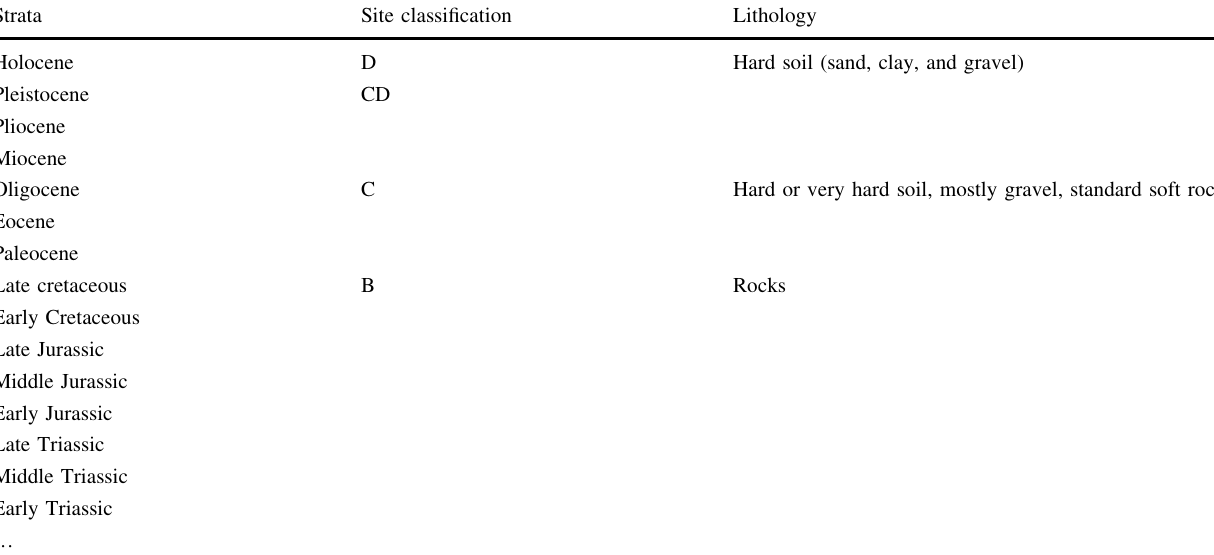
Table 1 Correspondence between stratigraphic units and site types in different geological ages. Source : Wills et al. (2000) Strata